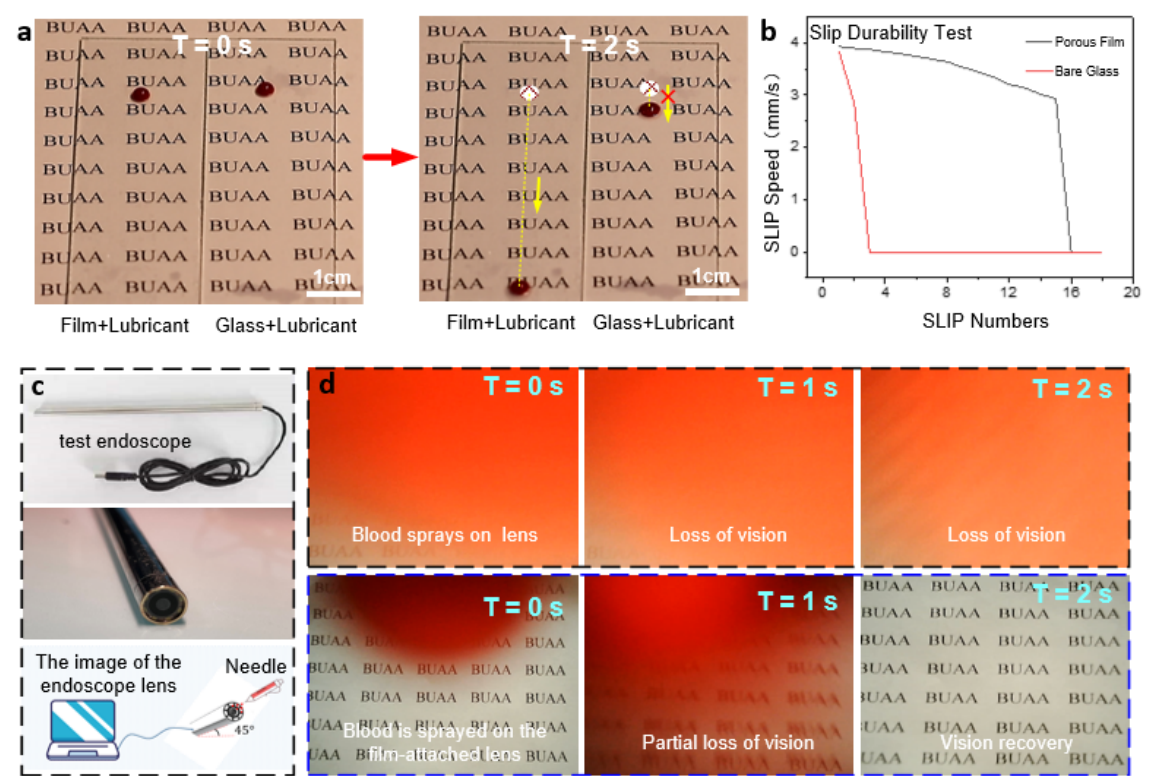
Figure 6. ( a ) Experimental graphs comparing the anti-adhesive performances of the porous film and ordinary glass. ( b ) Comparison curves of slip velocity between the two cases. ( c ) Test endoscope. ( d ) Endoscopic blood spray’s anti-adhesive test graphs (continuous images of the visual fields of the untreated lens ( top ) and lens with porous film ( bottom )).